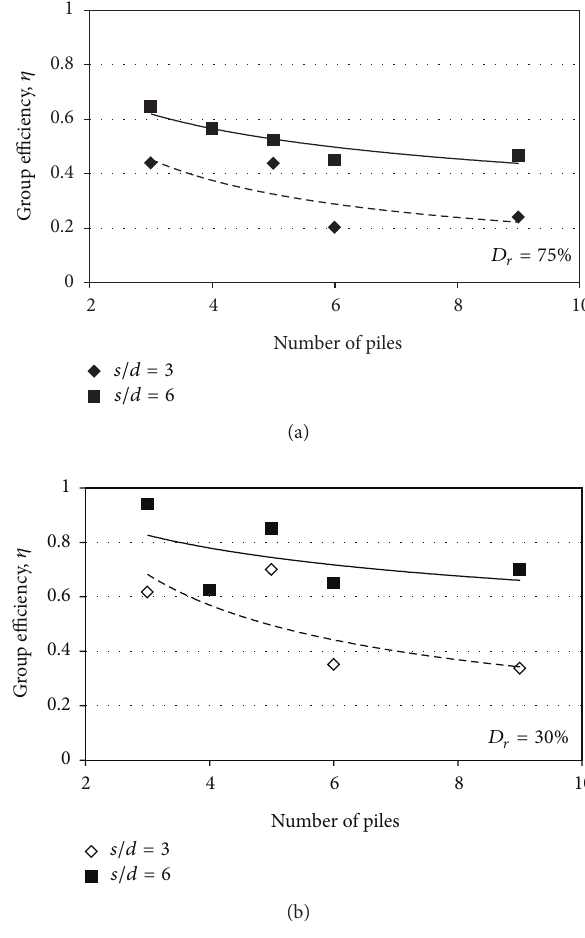
Figure 13: Group efficiency VS number of piles; (a) 𝐷 𝑟 =75% and (b) 𝐷 𝑟